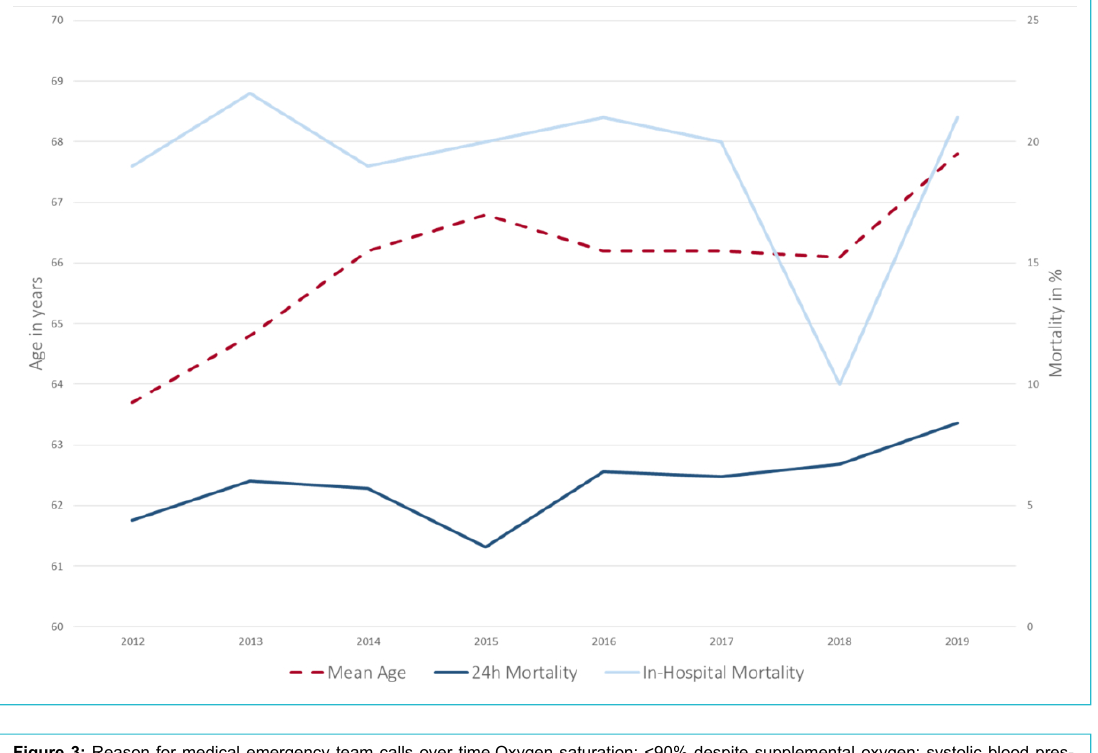
Figure 3: Reason for medical emergency team calls over time.Oxygen saturation: <90% despite supplemental oxygen; systolic blood pres- sure: <90 mm Hg; Glasgow coma scale (GCS): <13/15 or a drop by ≥2 points; heart rate: <40/min or >140/min; seizure: repeated or prolonged (>5 min); respiratory rate: <6/min or